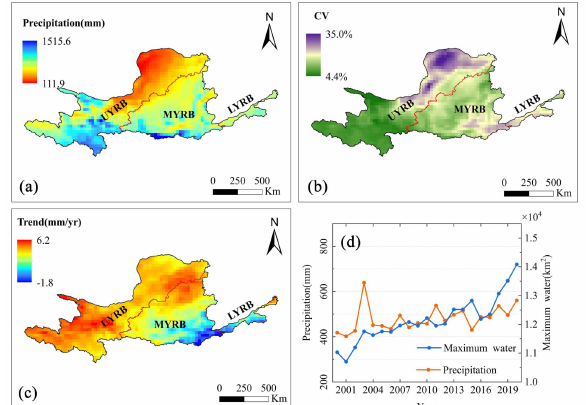
Figure 11. Interannual spatiotemporal variation of precipitation in the YRB from 2000 to 2020. (a) Spatial distribution of multi- year mean precipitation. (b) Spatial distribution of the CV (coefficient of variation) of multi-year precipitation. (c) Spatial distribution of the trend of multi-year precipitation. (d) Time- series precipitation and the maximum area of surface